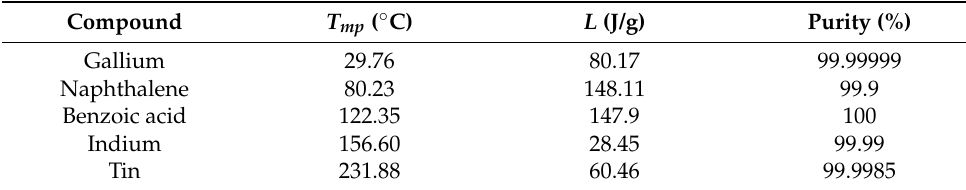
Table 2. Standard calibration substances